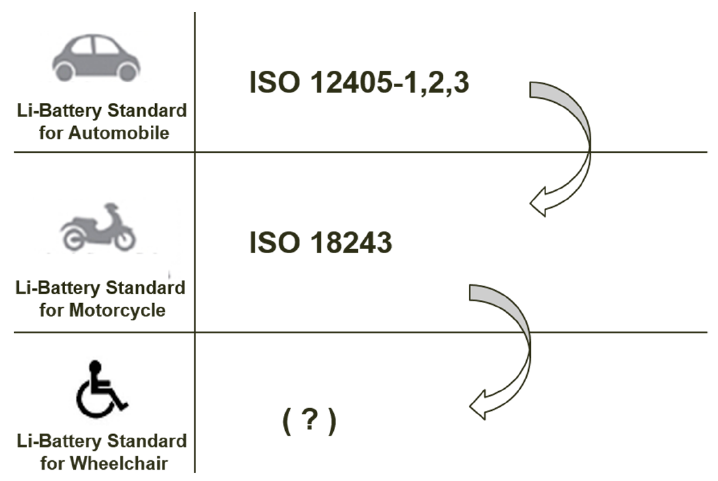
Figure 2. Process for establishing medical wheelchair standard.